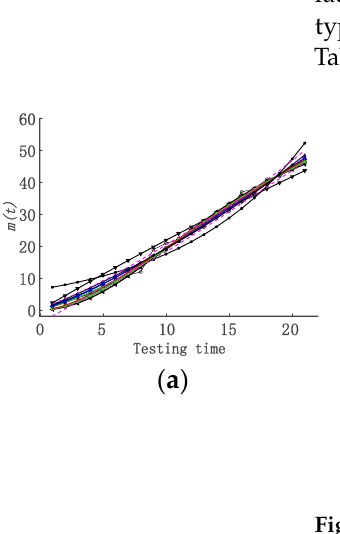
Figure 4. Fitting Curves of Models. ( a ) Fitting Curves of Models on DS1; ( b ) Fitting Curves of Models on DS2; ( c ) Fitting Curves of Models on DS3.